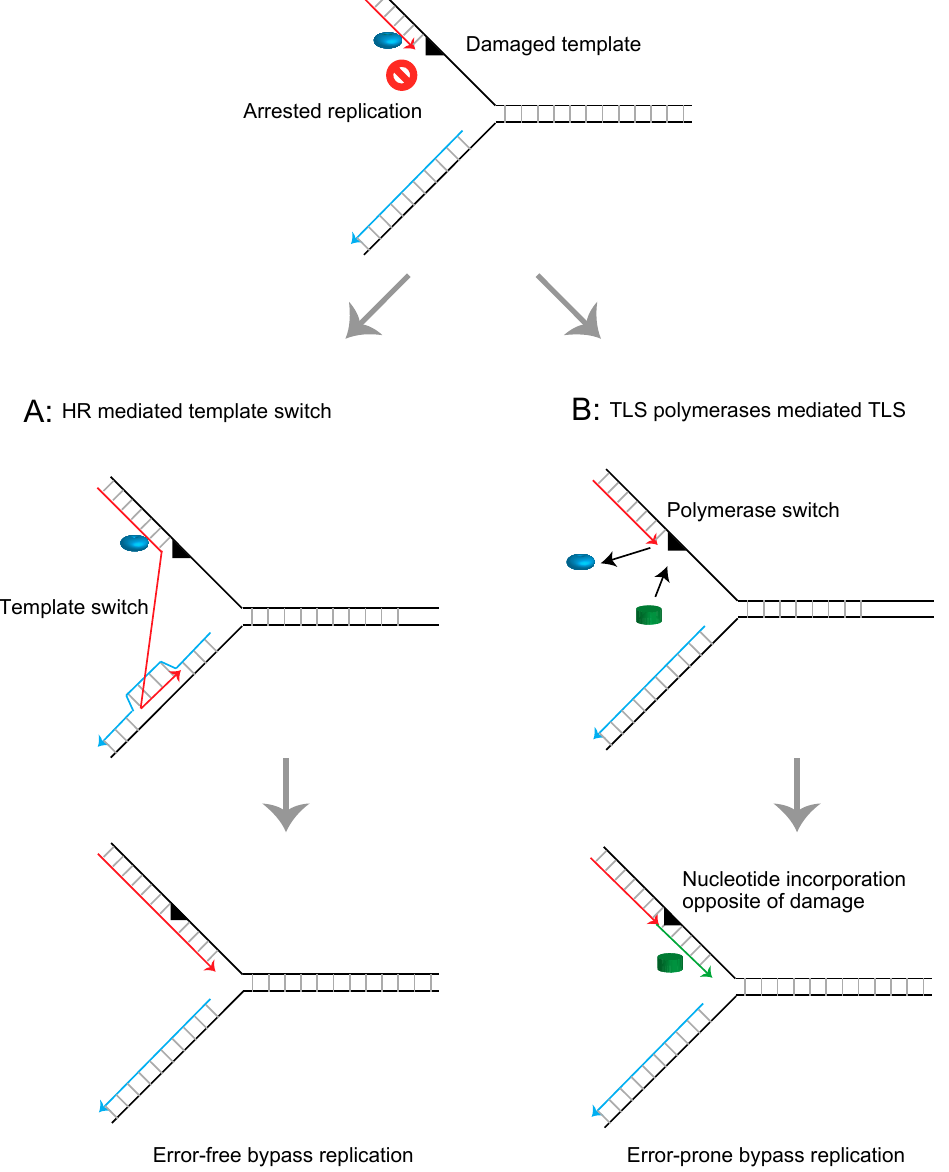
Figure 1. Schematic representation of mechanisms releasing the arrested replication fork at the damaged template. ( A ) Homologous recombination (HR)-mediated template switch releases the arrested replication fork using intact newly synthesized DNA as the template strand and promotes error-free bypass replication. ( B ) Translesion DNA synthesis (TLS) polymerases mediate direct bypass replication across the damaged template in an error-prone manner.